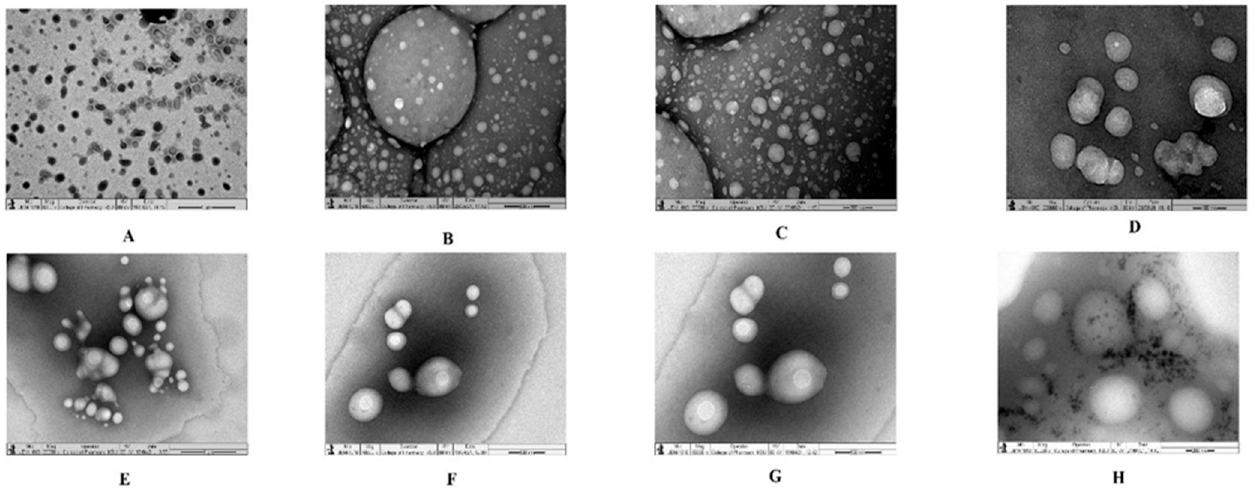
Figure 2. Transmission electron microscope study of nanovesicles. ( A ) Lyophilized recombinant HBsAg loaded docosahexaenoic acid nanovesicles at × 6000 magnification; ( B ) lyophilized recombinant HBsAg loaded docosahexaenoic acid nanovesicles at × 50,000 magnification; ( C ) lyophilized recombi- nant HBsAg loaded docosahexaenoic acid nanovesicles at × 80,000 magnification; ( D ) lyophilized recombinant HBsAg loaded docosahexaenoic acid nanovesicles at × 200,000 magnification; ( E ) liquid form of recombinant HBsAg loaded docosahexaenoic acid nanovesicles at × 30,000 magnification; ( F ) liquid form of recombinant HBsAg loaded docosahexaenoic acid nanovesicles at × 40,000 mag- nification; ( G ) liquid form of recombinant HBsAg loaded docosahexaenoic acid nanovesicles at × 50,000 magnification; ( H ) liquid form of recombinant HBsAg loaded docosahexaenoic acid nanovesi- cles at × 80,000